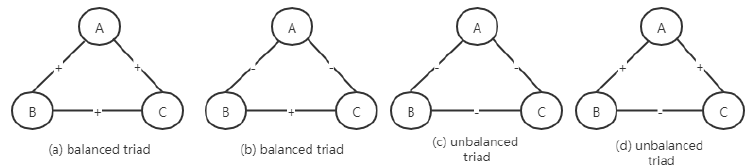
Figure 2. Triad structure in structural balance